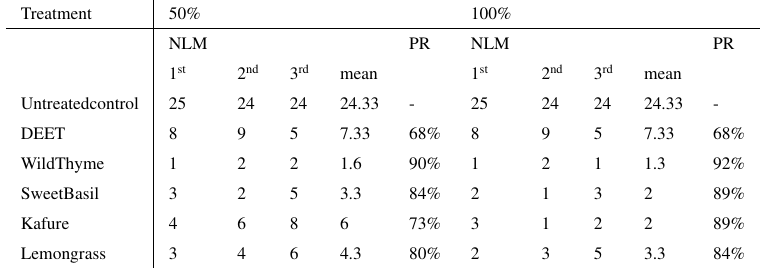
Table 5. Percent repellency according to the number of landed mosquitoes (NLM) of 50% and 100% percent of evaluated plants leaves hexane extract against Anopheles mosquito. Treatment